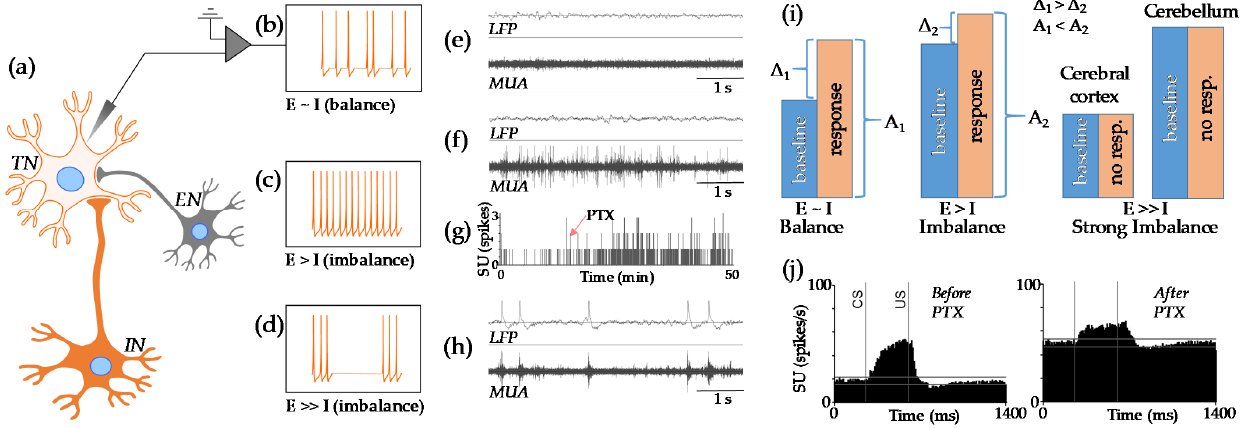
Figure 1. A schematic illustration of E-I physiology and balance. ( a ) A target neuron (TN) receives input from both inhibitory (IN) and excitatory neurons (EN). ( b ) If these inputs are “balanced”, TN fires relatively slowly. ( c ) If the inhibitory input is weak, the firing rate of TN increases. ( d ) If the inhibitory input is absent, TN can go into a seizure state. Additionally, we illustrated this scheme with examples of actual recordings. Local field potentials (LFP), multi-unit activity (MUA) and single units (SU) were recorded from layer IV of somatosensory cortex in awake adult rabbits (for experimental setup see [40]). ( e ) In the absence of stimulation, the baseline activity in somatosensory cortex can be very slow. ( f ) However, after the local injection of the gamma aminobutyric acid (GABA)-antagonist picrotoxin (PTX, 0.06 nmol/ µ L), neuronal activity visibly increased. ( g ) This effect is further shown in the temporal dynamics of spikes in a selected SU. Note that this neuron was nearly silent before injection. The red arrow indicates the time of the injection. ( h ) If the dose of PTX is higher (0.3 nmol/ µ L), both LFP and MUA go into seizure (functionally failed) states. ( i ) For these three scenarios the stimulus processing is characterized by a strong relative response to stimulation under a balanced state, by a weaker relative but higher in absolute magnitude response to stimulation under a slightly imbalanced state and by the absence of a response under a failed state (strong imbalance). Note that the nature of failed state depends on the brain structure. For example, in the cerebral cortex the failed state is related to seizure activity while in the cerebellum the failed state is related to the saturation of the neuronal response in highly elevated baseline. ( j ) Our actual data [70] illustrates the observation of a relatively small and strong imbalance (not shown). Activity of single units (N = 55) was recorded from deep cerebellar nuclei before and after injection of PTX (2.5 nmol/ µ L). PTX increased both baseline activity and the level of absolute response to conditioned (CS) and unconditioned (US) stimuli but decreased the relative (to the baseline)